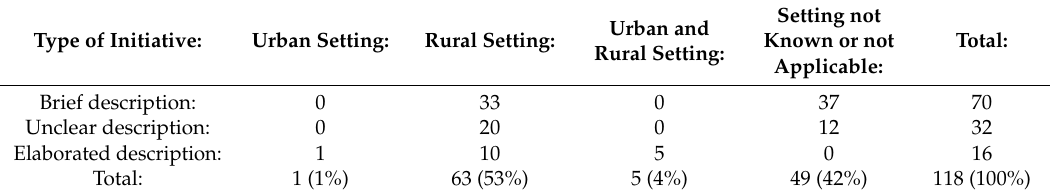
Table 2. Overview of municipal initiatives in Sweden, highlighting the context focused upon in the initiative (urban and/or